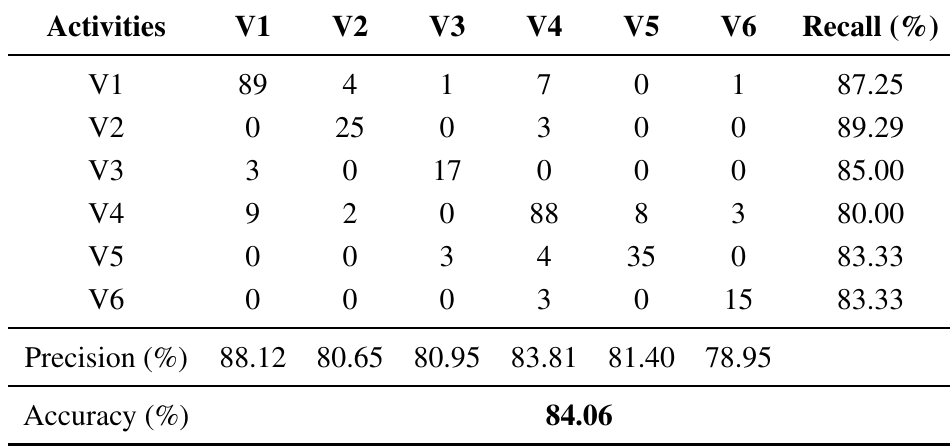
Table 4. Confusion matrix of the SVM classifier using LDA for the vertical traffic.